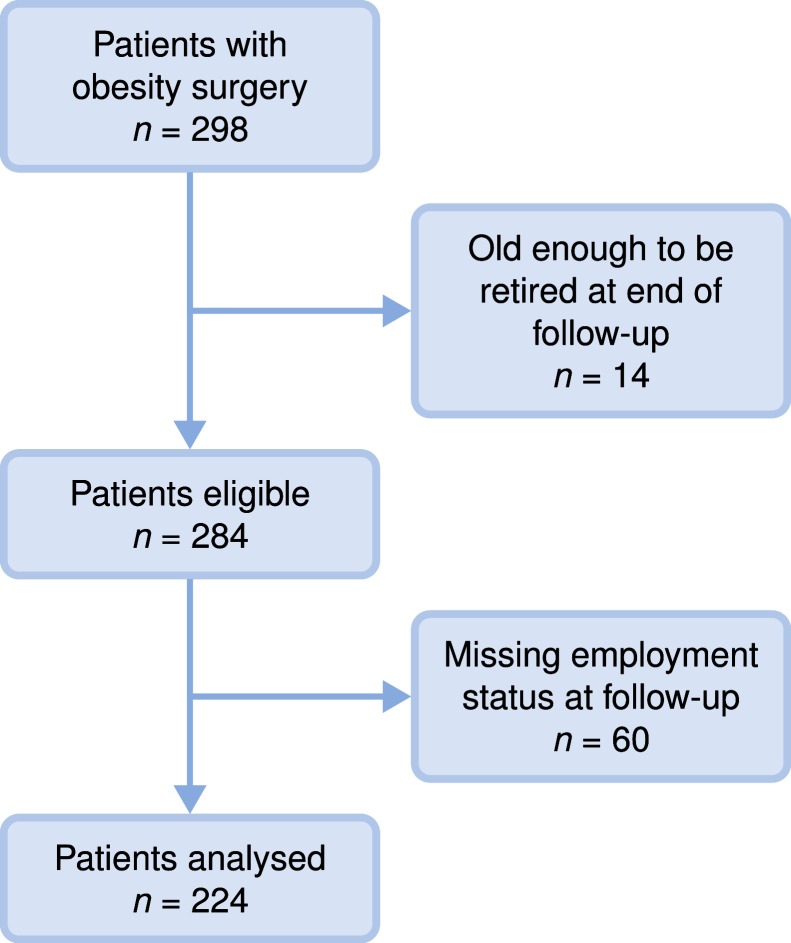
Study population flow chart.